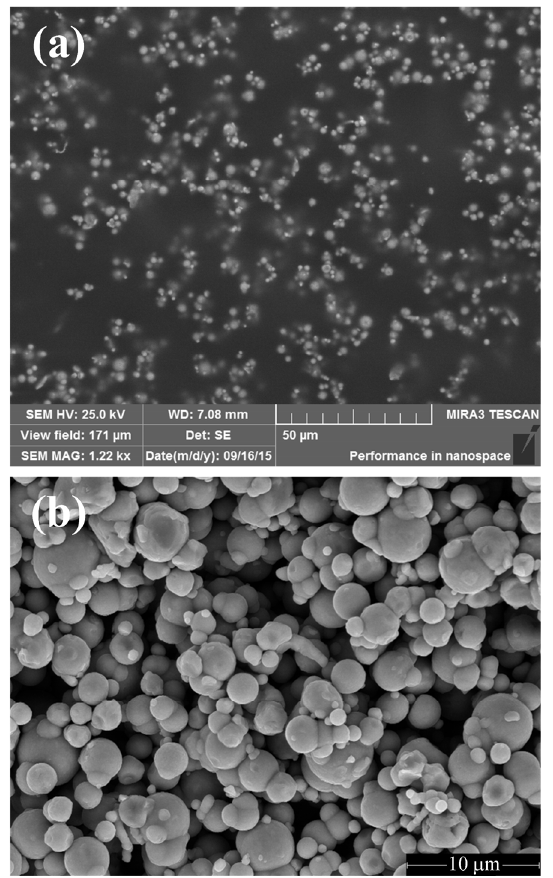
Fig. 10 (a) SEM micrograph of the MRE sample and (b) the microstructure of CIPs.